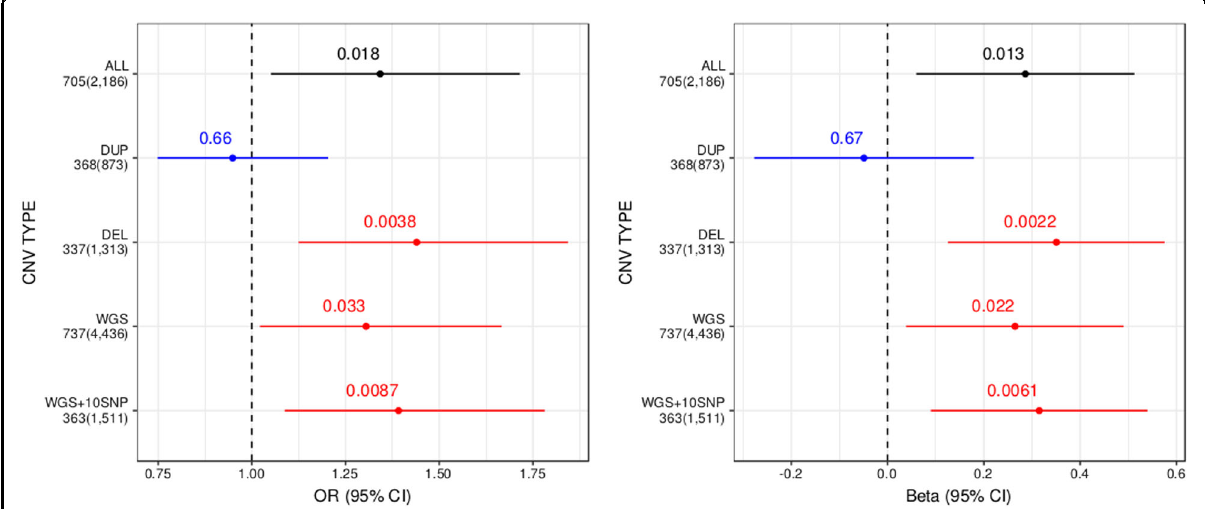
Fig. 3 Forest plot displaying the mean and con fi dence interval of regression coef fi cients of rare variant burden analysis for CNVs. We compared the burden of genes affected by rare CNVs in the BP1-related gene set between BP1 individuals and controls, strati fi ed by a detection method (microarray or WGS) and a CNV type. The total number of CNVs detected and the number of CNVs affecting BP1-related genes are displayed for each category. The black line indicates results of all microarray CNVs, the blue line indicates results of duplications from microarray, red lines indicate results of deletions from microarray (DEL) and WGS (WGS and WGS + 10SNP) data. WGS + 10SNP is results of WGS deletions covered by at least 10 SNPS on the microarray. To correct for individual relatedness and other potential confounders (see Methods), enrichment was assessed using a generalized linear mixed model (left) and a linear mixed model